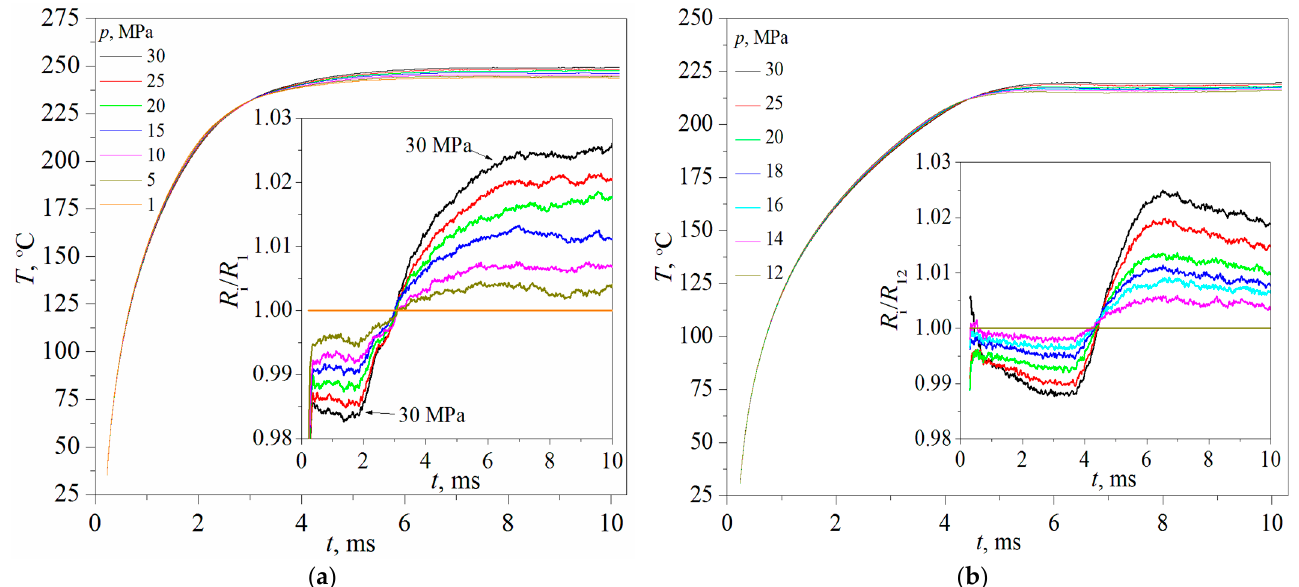
Figure 6. ( a ) Heating curves for a mixture containing 30 wt.% PPG-425 under the mode of constant power. The parameter is the excess pressure value. Inset: change in the relative thermal resistance of the mixture over time; ( b ) heating curves for a mixture containing 20 wt.% PPG-425 under the same thermal mode and experimental parameters.